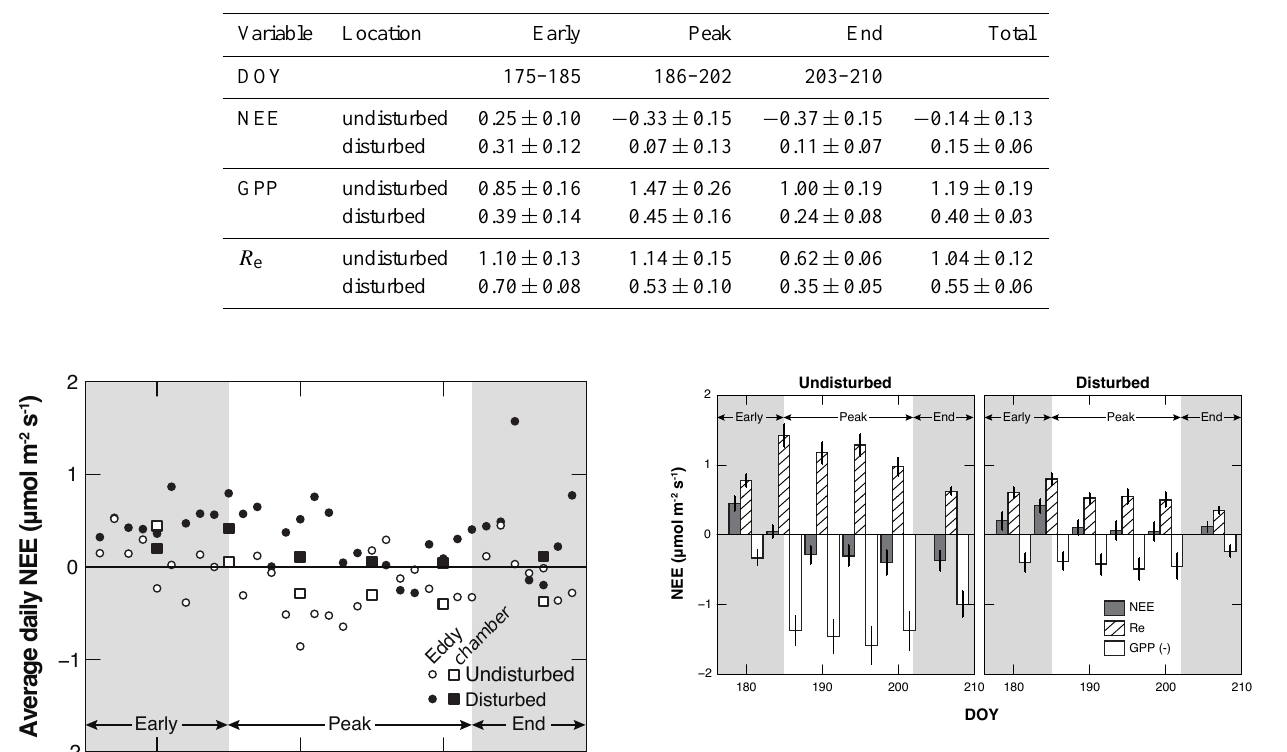
Figure 8. Partitioning of NEE data from static chamber measure- ments into component fluxes, GPP and R e , for the undisturbed and disturbed sites. Measurements were made in 21 collars during day- time hours in each of the disturbed and both undisturbed footprint areas of the EC